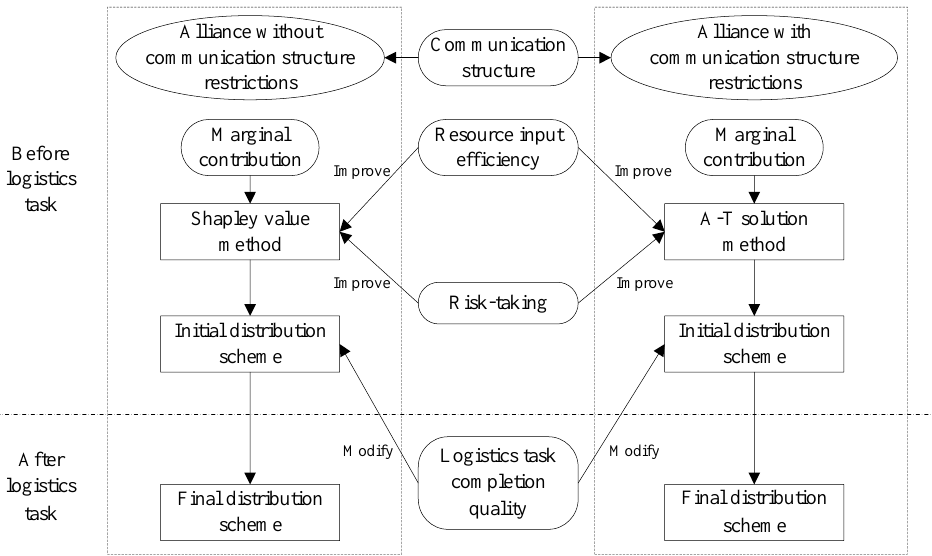
Figure 2. Two-stage profit distribution model for logistics alliance with two types of communication structures.